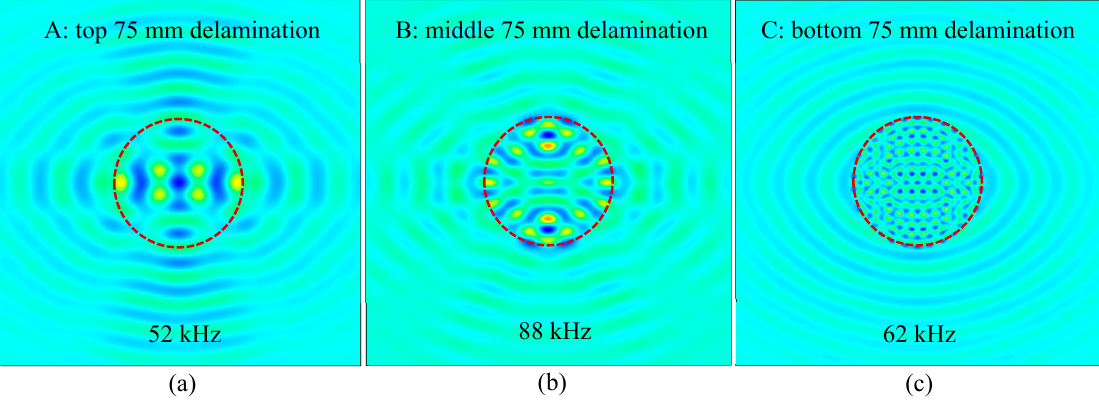
Figure 17. FEM-measured operational vibration shapes of delaminations at different depths in the unidirectional CFRP composite plate: ( a ) top 75 mm delamination at 52 kHz; ( b ) middle 75 mm delamination at 88 kHz; ( c ) bottom 75 mm delamination at 62 kHz.